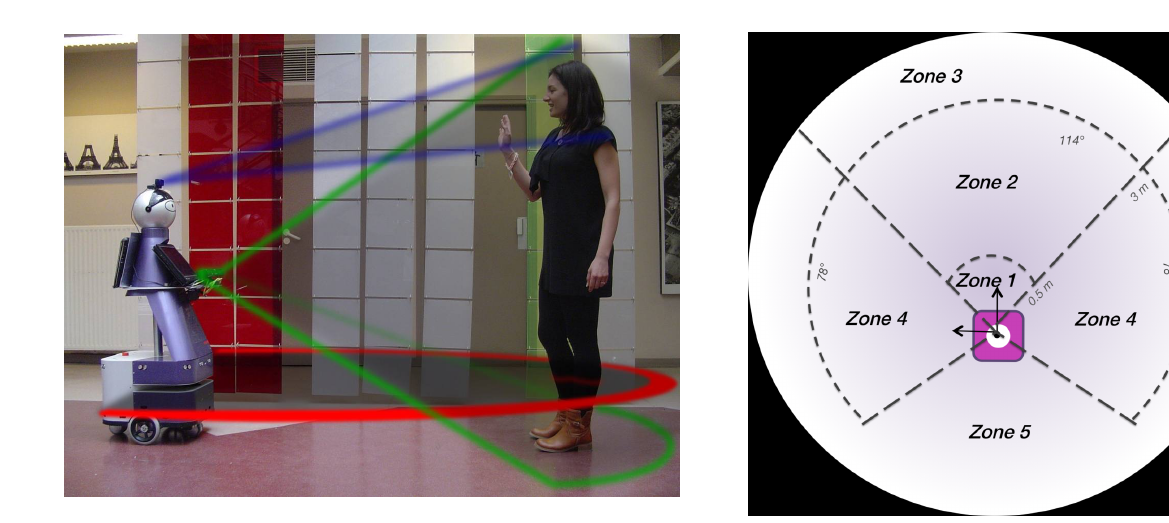
Figure 2. The FoV of RGB camera, Kinect (RGB and depth cameras) and laser sensor embedded in the robot Kompaï. The FoV of the microphones array is not represented because it has an angle of view of 360 ◦ .